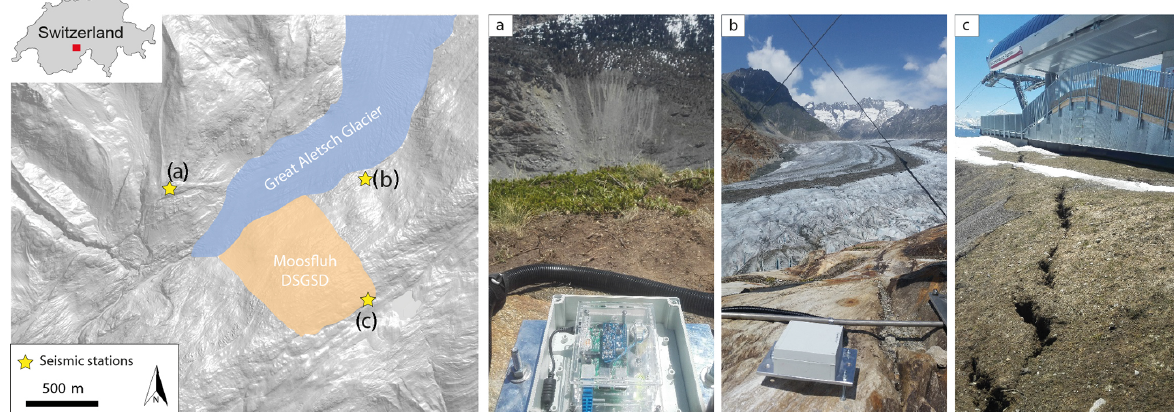
Figure 1. (left panel) Map of the area of investigation with indication of the location of the three RS seismic stations starting from May 2017. (a–c) Pictures of the RS installation ( a , RS-1; b , RS-2; c , RS-3). Continuous records of seismic signals at the three stations are available since the beginning of July